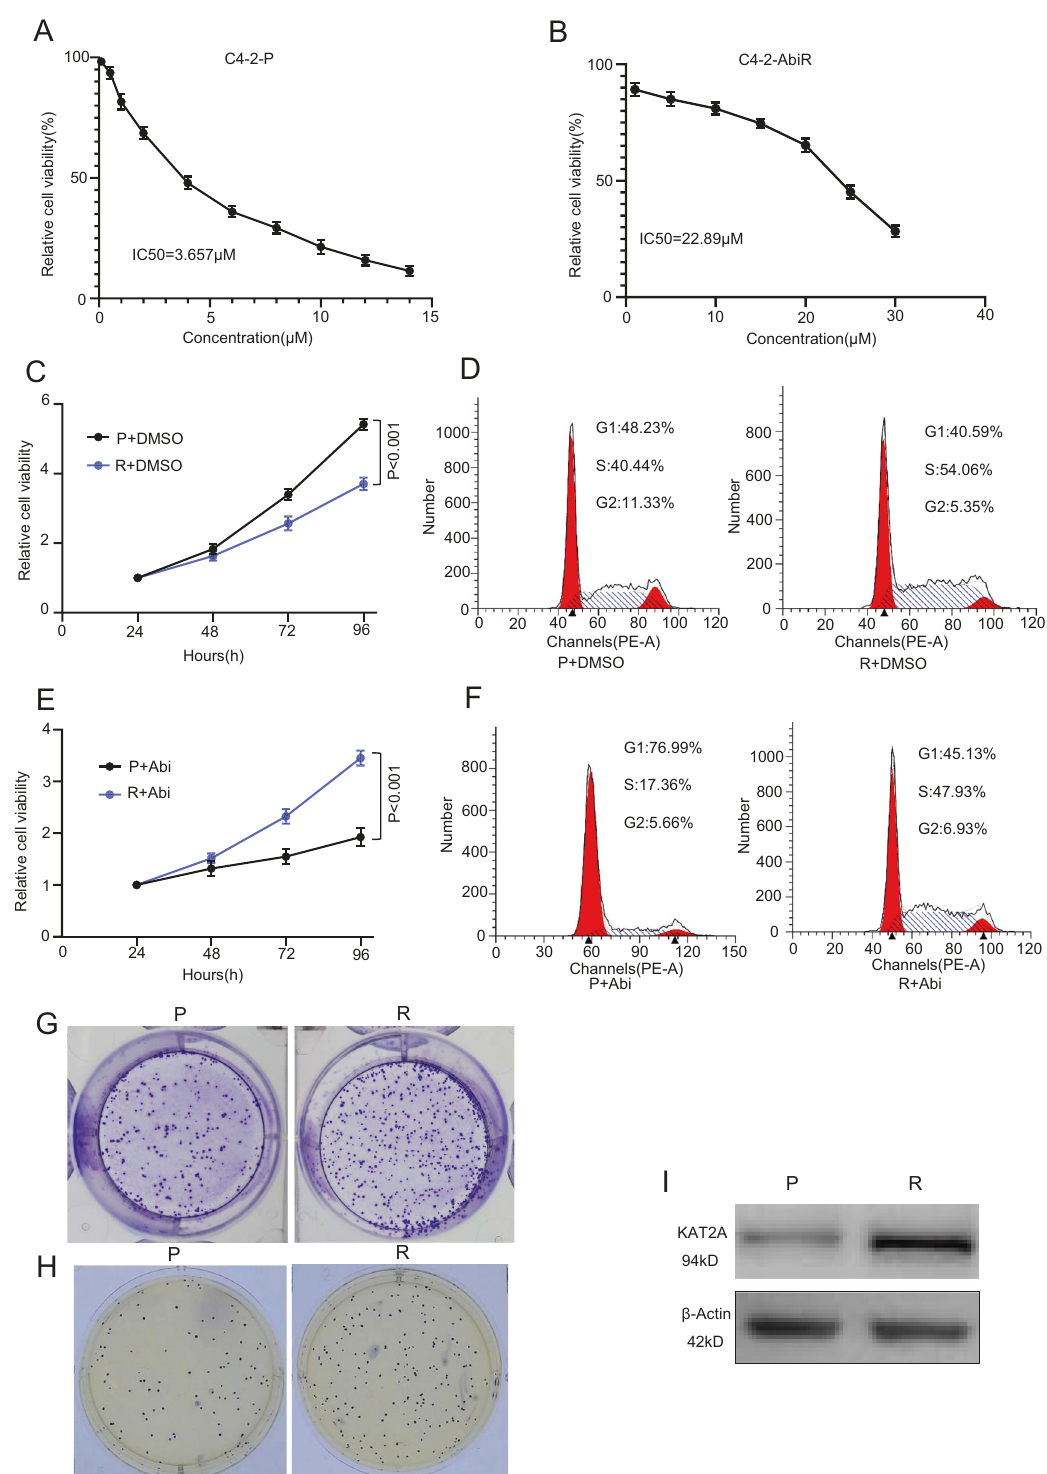
Fig. 2 KAT2A is up-regulated in the newly established C4-2-AbiR cell line. A, B IC50 of C4-2-P and C4-2-AbiR tested by CCK-8. C, E Relative cell viability of C4-2-P and C4-2-AbiR with or without abiraterone detected by CCK-8. D, F Cell cycle of C4-2-P and C4-2-AbiR with or without abiraterone detected by fl ow cytometry. G, H Proliferation of C4-2-P and C4-2-AbiR showed by colony formation and soft agar assay. I The protein expression of KAT2A in C4-2-P and